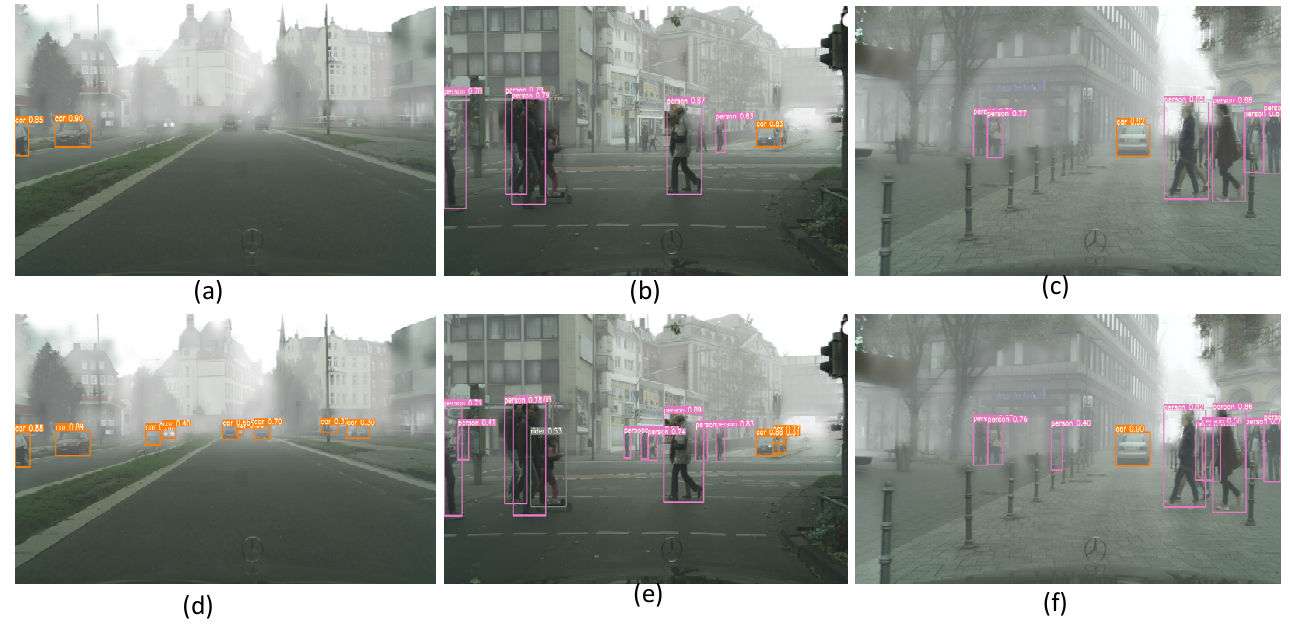
Figure 3. Object detection display. In the presence of large domain offsets, our spatially aligned selective domain adaptation framework enables YOLOv5 to produce more accurate detection results than training only on the source domain. ( a – c ): The detection results of the Source Only model. ( d – f ): The detection results of the proposed method.